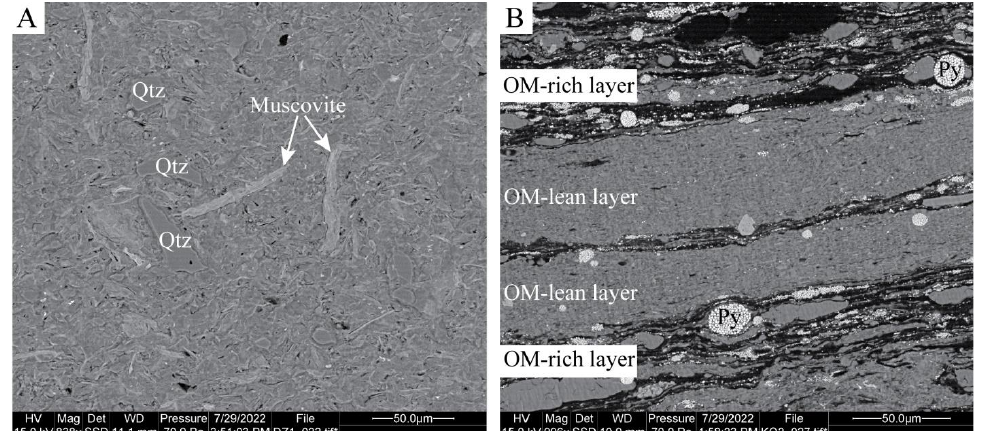
Figure 3. SEM images showing the mineralogical composition and fabric of the studied Chang 7 Member shale samples. ( A ) Quartz and muscovite grains dispersed in the clay matrix. Sample DZ-1. ( B ) Intercalation of OM-rich and OM-lean layers. Sample KQ-2. SEM images also show that samples from the KQ have higher OM contents than those from the DZ section. Qtz = quartz; OM = organic matter; Py =